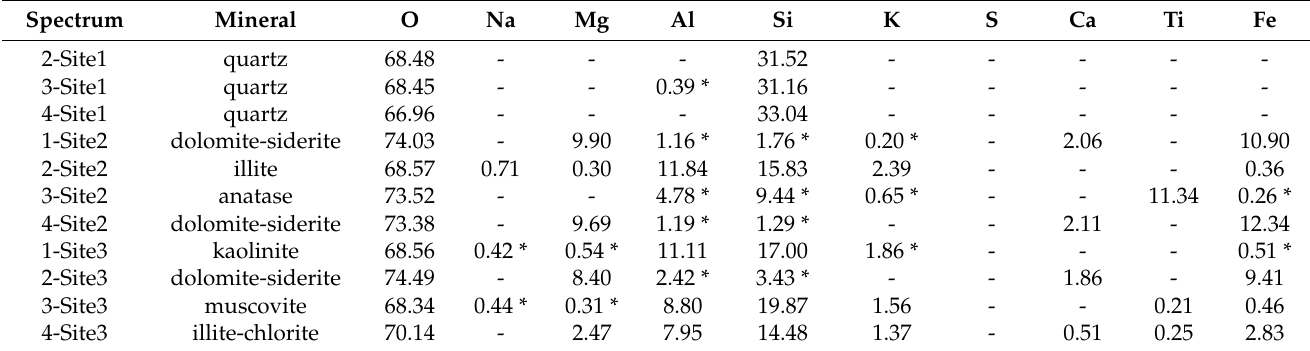
*: Contamination from close minerals. Refer to Figure 6 for details on spectrum and site number.